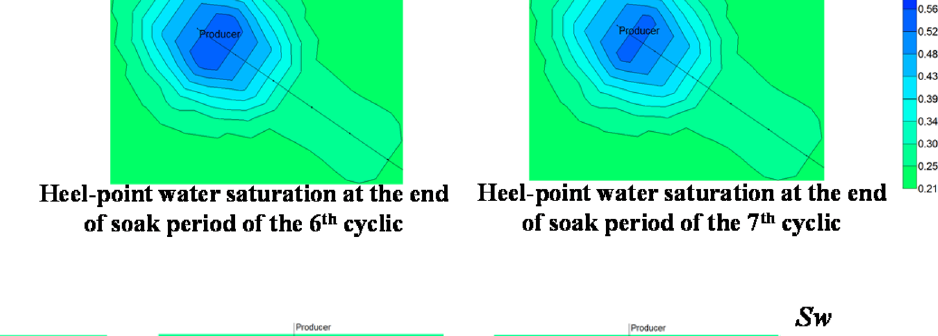
Fig. 6 Interpretation for the fluctuation phenomenon of cyclic oil production when the horizontal well is close to the bottom